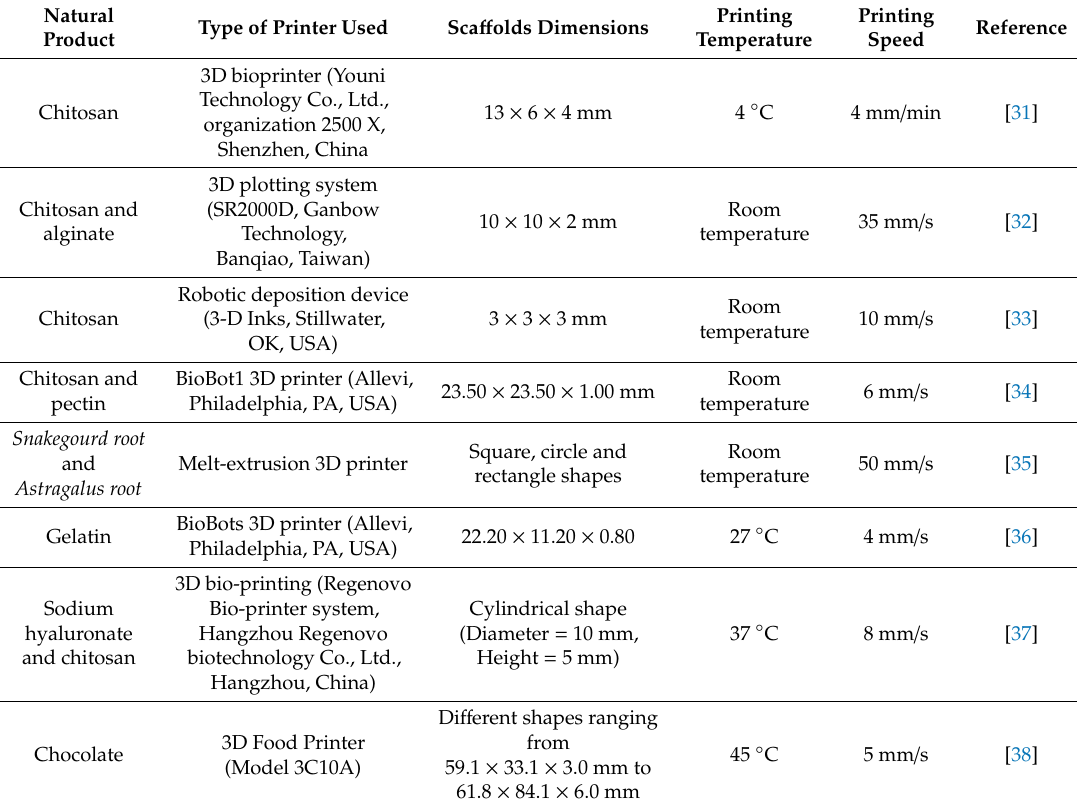
Table 1. Printing conditions and sca ff olds dimensions of PAM 3D printed systems containing natural